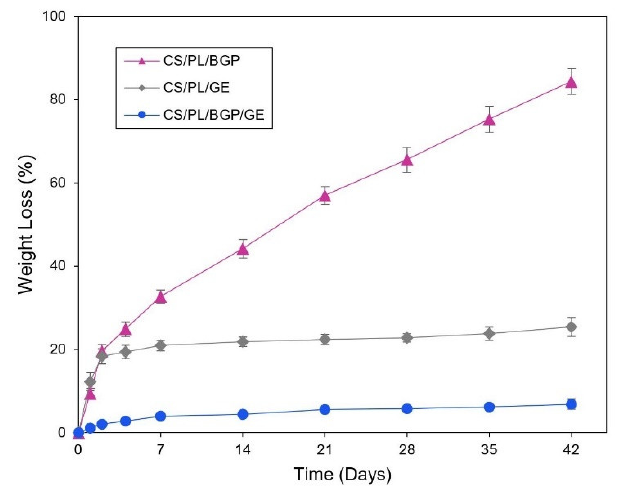
Figure 7. In vitro biodegradation profiles of CS/PL-based hydrogels prepared with BGP ( ), GE ( ), and both BGP and GE ( ). ), GE ( ),